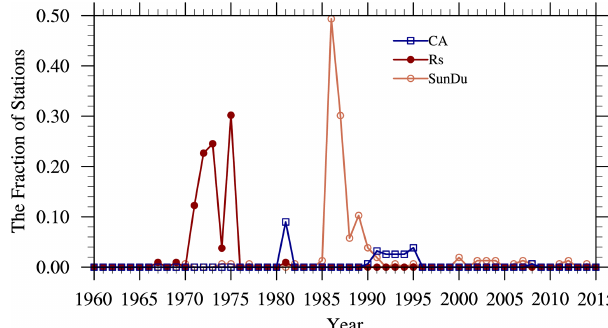
Figure 3. The anomalies of surface incident solar radiation ( R s ) de- rived from homogenized sunshine duration (SunDu) data (red line) by the RHtests QM method and other independent data (blue line) adjusted by the method in Katsuyama (1987). Both of the homoge- nized datasets yield nearly the same R s